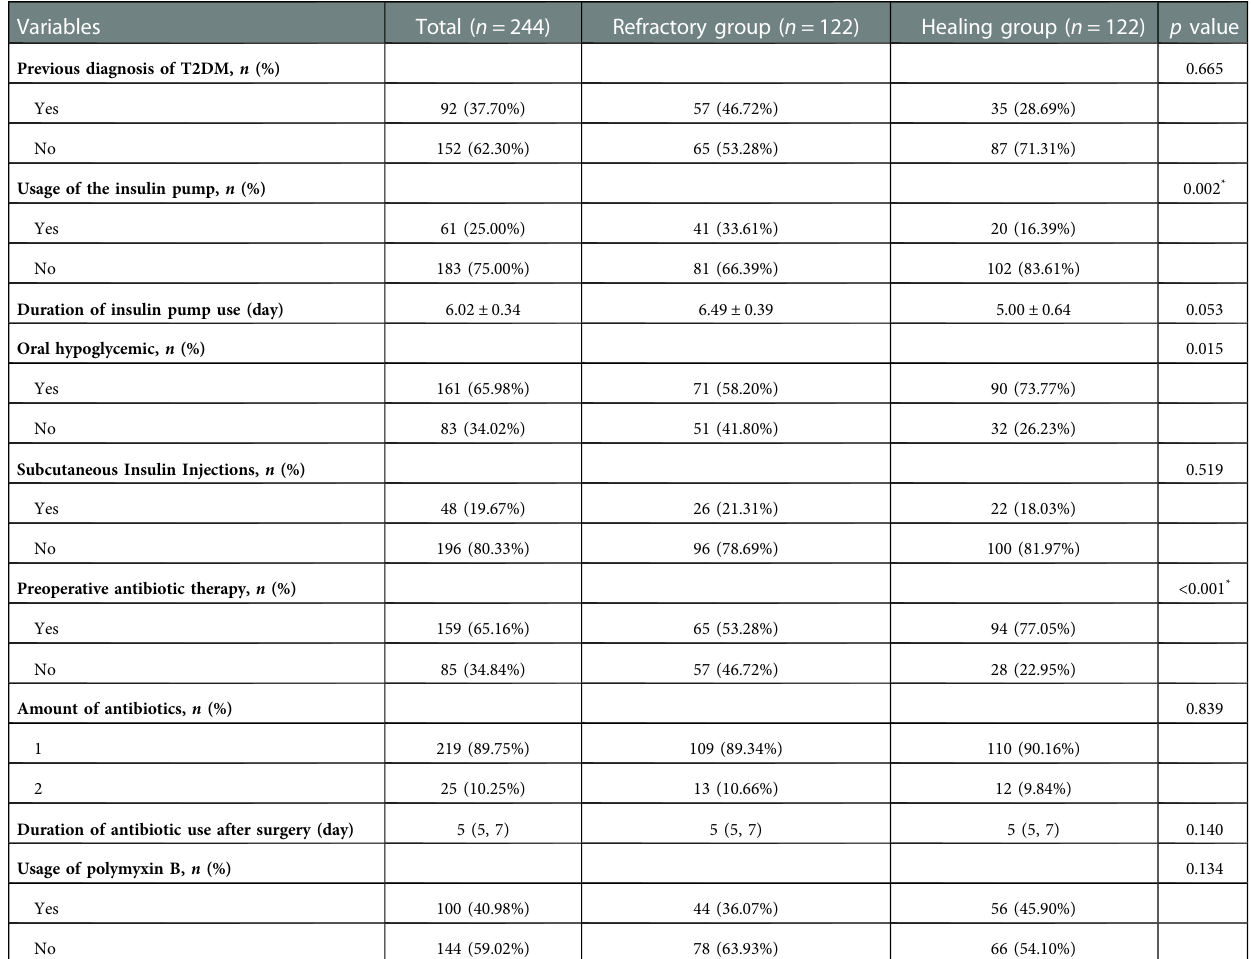
TABLE 4 The treatment of anal fi stula combined with